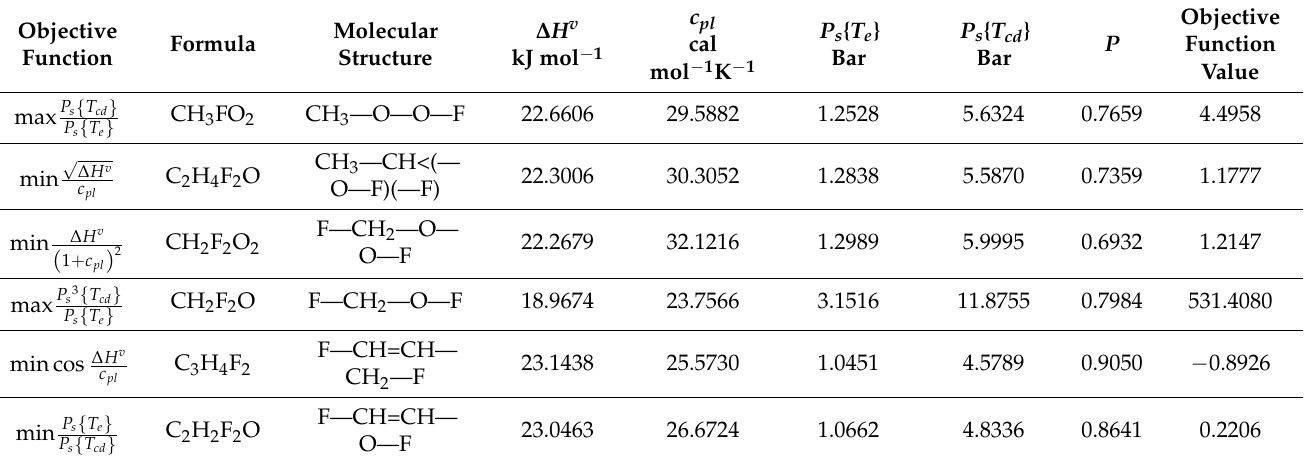
Table 2. Objective function and its value, formula, molecular structure, physical properties, and the performance values of the new